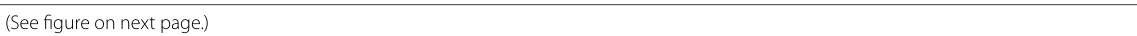
respectively(See figure on next Fig. 3 Binding mode and interaction map. a Molecular docking of berberine into the 6-HB structure. The location of the potential interacting eight residues were highlighted. Berberine is colored by atom type: Carbon (black), oxygen (red), nitrogen (blue). The hydrogen bond was drawn as green dotted lines. Distance (Å) between interacting atoms was marked in green. b 3D representation of different interactions of compound berberine with residues in the binding sites of NHR and CHR of gp41. The highlighted orange spheres represented T-639 and red spheres represented oxygen atom (O). c Binding mode of compound berberine in the active region of gp41. The NHR and CHR helices were indicated in silver, the compound was rendered in yellow stick model and the residues were rendered in green, blue and purple sticks, respectively. d An enlarged detail view for C. The binding sites of eight amino acid residues were indicated in green, orange and blue,